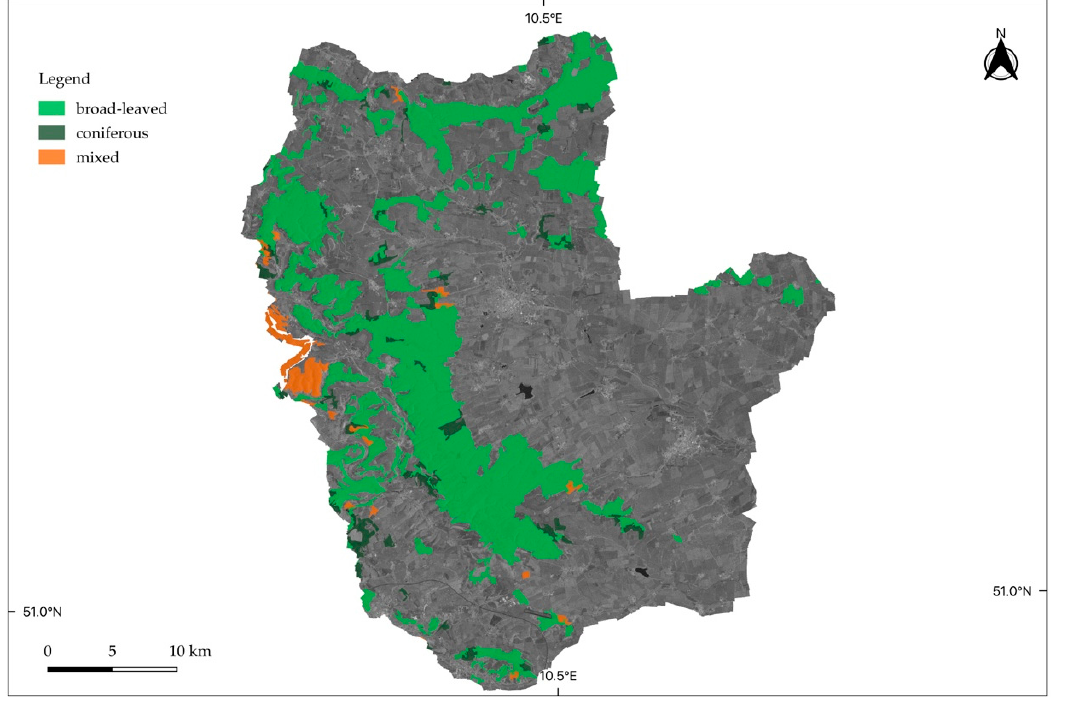
Figure 3. Location of the study site Hainich-Dün. Forest type cover information was taken from the Corine Land Cover Dataset 2018 (© European Union, Copernicus Land Monitoring Service 2021, European Environment Agency).